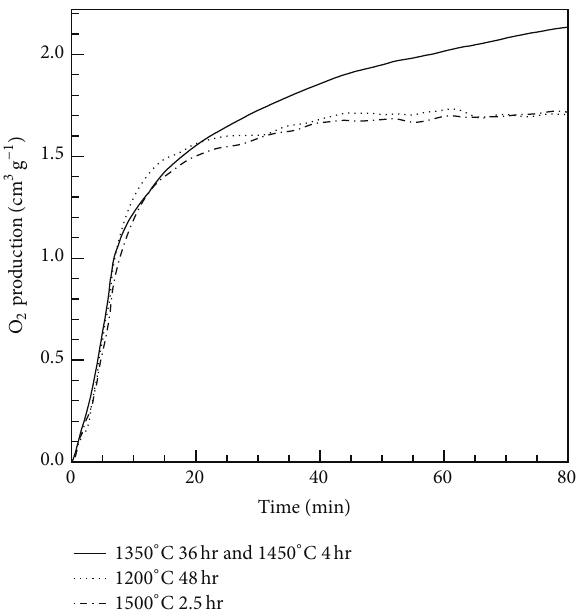
Figure 8: O 2 production versus time during the reduction step of the 4th